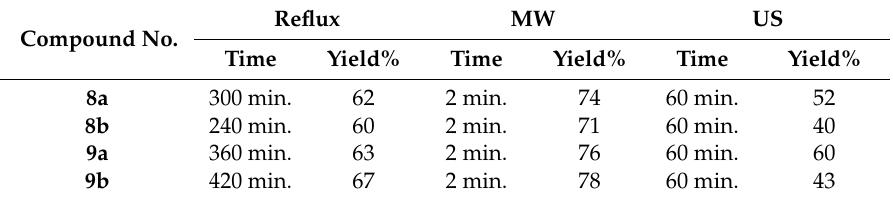
Table 1. Comparison between methods for the synthesis of compounds 8a , b and 9a , b . Compound No.